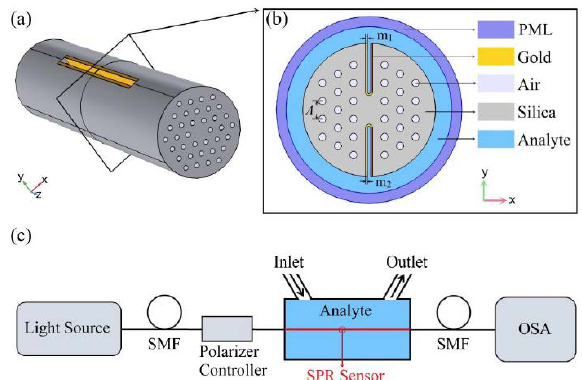
Figure 18. ( a ) Three-dimensional schematic view of the proposed H-shaped photonic crystal fiber-based surface plasmon resonance (PCF-SPR) sensor; ( b ) cross-section of the SPR sensor; ( c ) possible experimental setup of the SPR sensor for analyte RI detection. Figure reproduced under the terms of